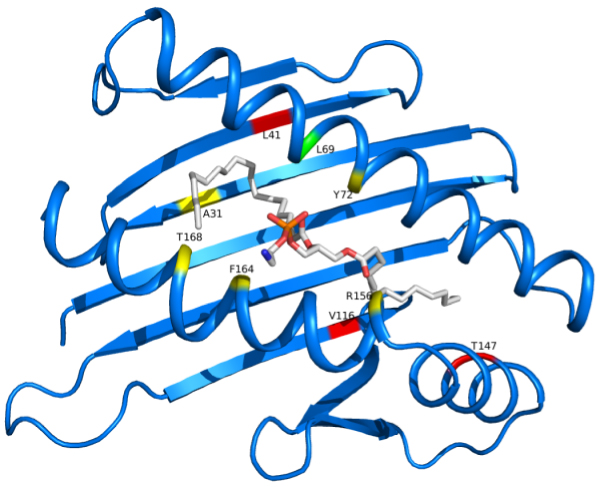
Key positions replaced in mutants with impaired ligand binding. Wild type EPCR residues are represented as colored spots corresponding to the Cα position. L69 (in green) was found substituted only in single mutants. Residues substituted in both single and double mutants are in yellow, while those observed in double mutants only are in red. PTY ligand is represented in sticks. Figure is drawn with Pymol (DeLano Scientific, San Carlos, CA, USA).